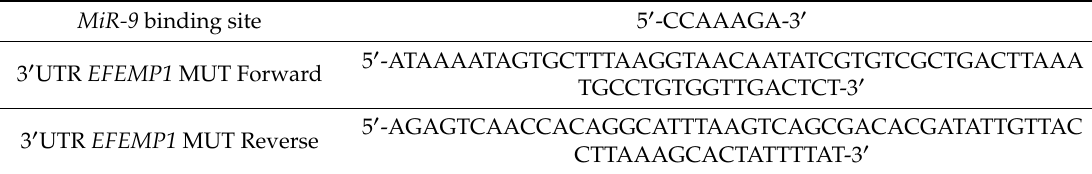
Table 3. Template primers for mutagenesis (mutated sites